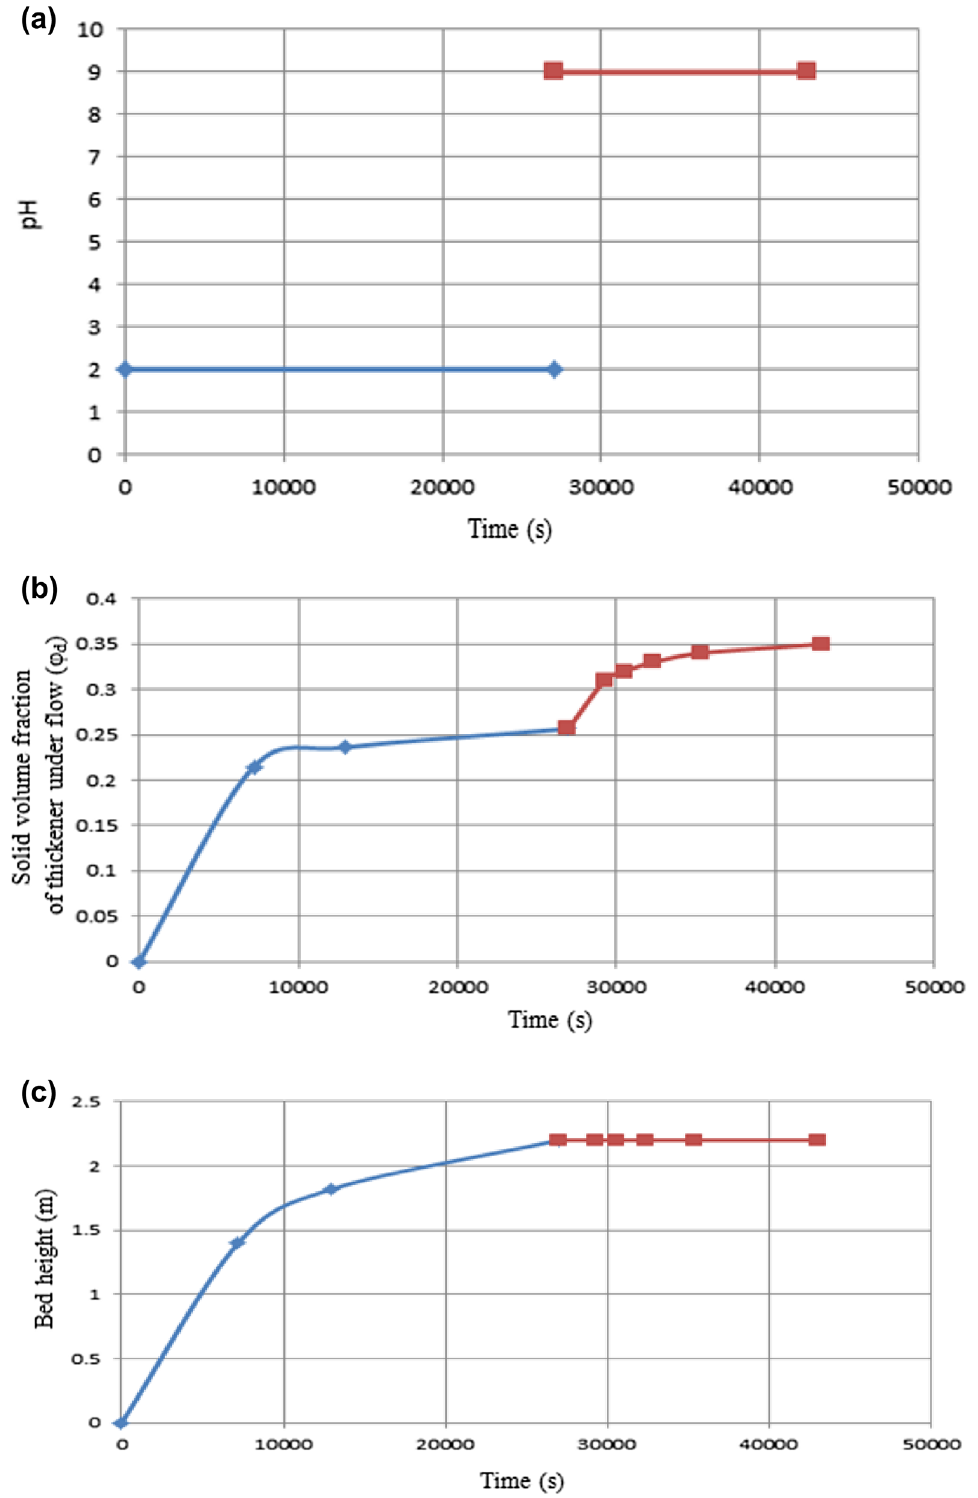
Fig. 5 The time-dependent variation of pH of input feed to the thickener and simulation of changes of response variables for the conditions: d 80 = 275 l m, F = 40 g/t, First pH 2 and then pH